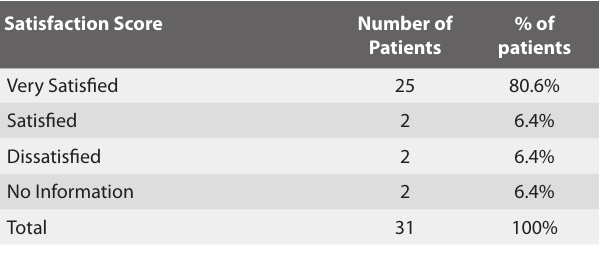
Table 3. Satisfaction scores with video